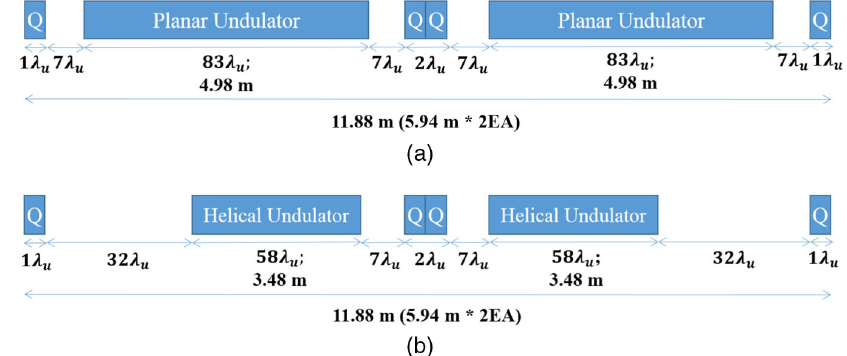
FIG. 2. The beam transport magnet lattice unit in the PAL-XFEL undulator line: (a) planar undulator line and (b) helical undulator line. Q means a half part of a quadrupole magnet. λ u is the undulator